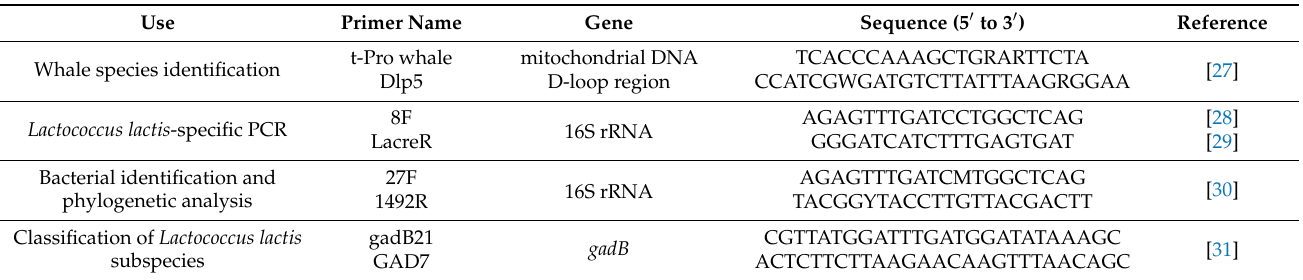
Table 1. PCR primers used in this